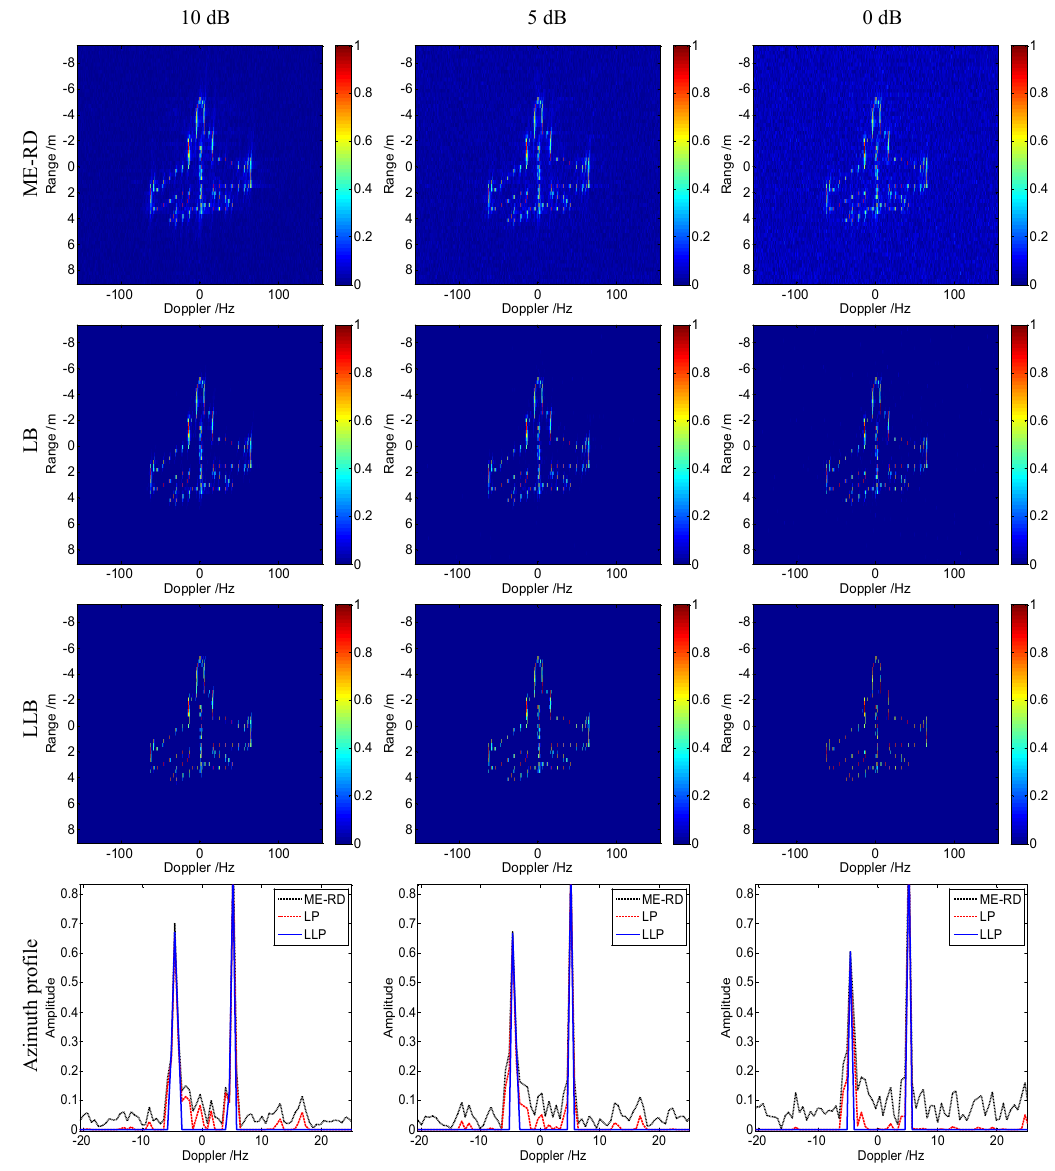
Figure 5. Imagery results of Mig-25 under different signal to noise ratio (SNR) conditions.